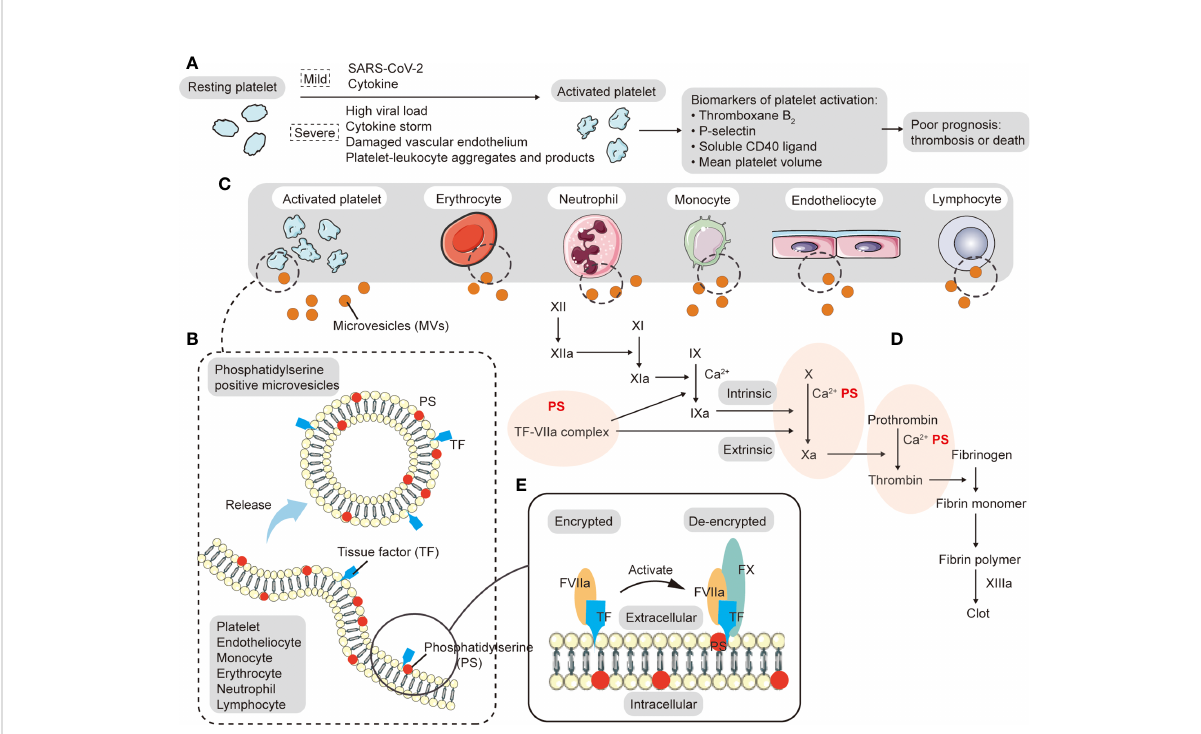
FIGURE 1 Origin and procoagulant activity of microvesicles (MVs). (A) During acute local in fl ammation, invasive SARS-CoV-2 triggers the immune response in which neutrophils and monocytes are recruited and cytokines activate platelets. When COVID-19 worsens, platelets are easily activated by high viral load, cytokine storm, damaged vascular endothelium, and platelet-leukocyte aggregates, forming widespread (micro-) blood clots in the body, which can lead to poor circulation, hypoxemia and multiple organ failure. Platelet activation markers (such as thromboxane